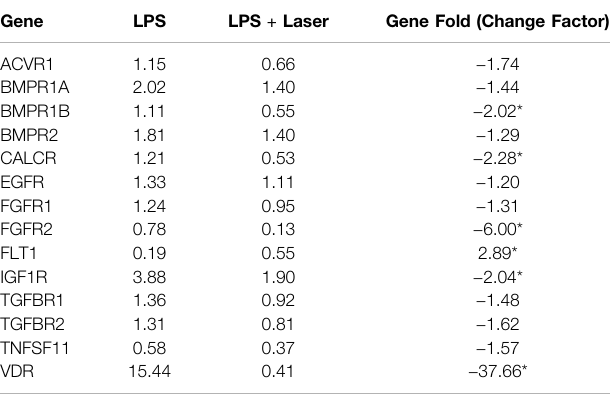
TABLE4| mRNAExpressionofCellularReceptorsRelatedtoOsteogenesisinthe DPSCs After and Before Laser Irradiation.